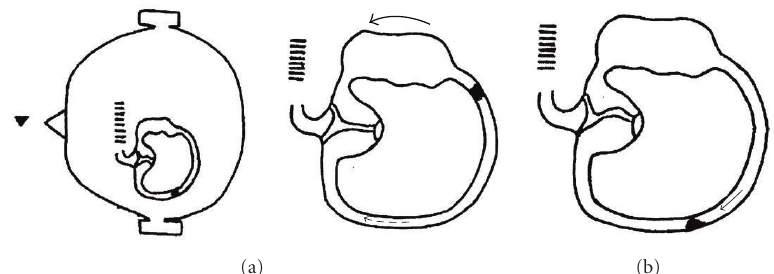
Figure 4: (a) In the end, when the patient in supine position moves his/her head from the right side to the left side (outer arrow), the endolymphatic flow (dashed arrow) is not able to move the debris in the posterior part of the canal towards the ampulla due to their weight. (b) It is only when the head is still that the debris suddenly falls, due to gravity, towards the cupula (thin arrow), provoking a violent left beating geotropic nystagmus (head